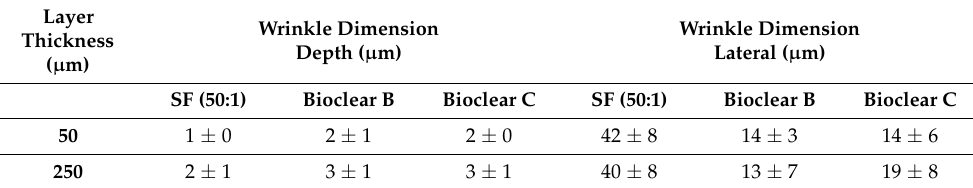
Table A5. Dimensions of the wrinkles generated on the soft PDMS substrates (SF, Bioclear B, and Bioclear C) upon deposition of a thin layer of PF.